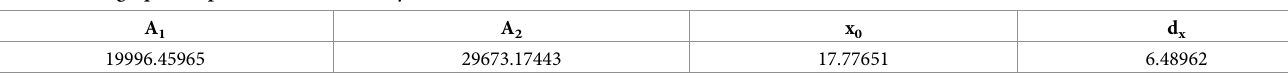
Table 25. Fitting equation parameters of efficiency of